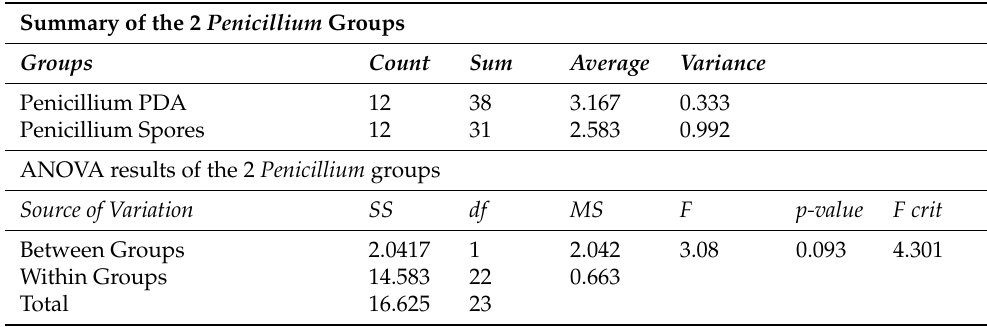
Table A4. ANOVA Single Factor Results comparing Penicillium with PDA and in